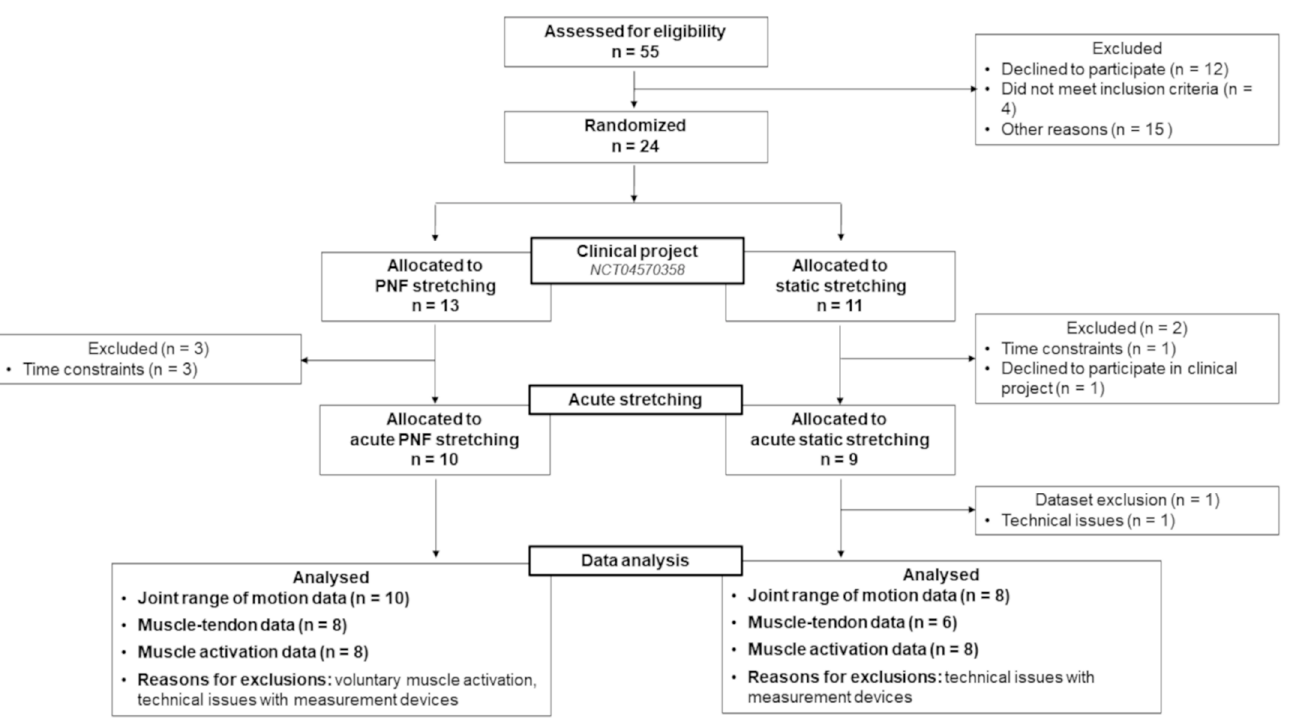
Figure 3. Flow diagram for the participants included in the present study.